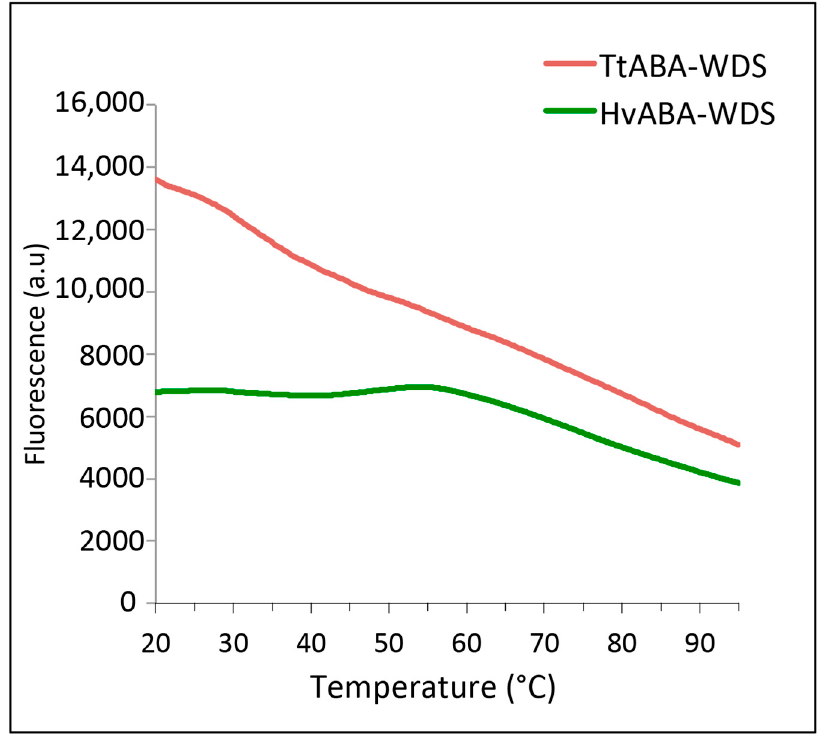
Figure 4. Differential scanning fluorimetry (DSF) of TtABA-WDS and HvABA-WDS domains in the presence of Sypro Orange in the 20–95 °C temperature range.